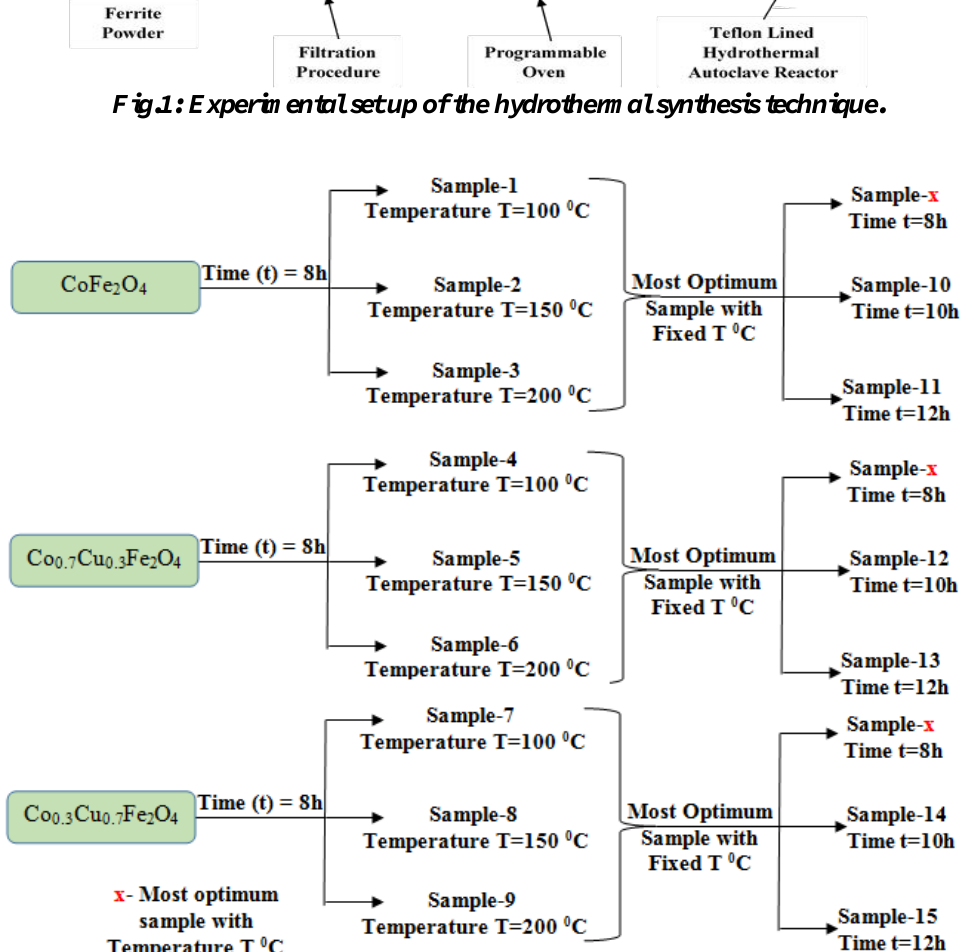
Fig.2: The diagram of the hydrothermal synthesis